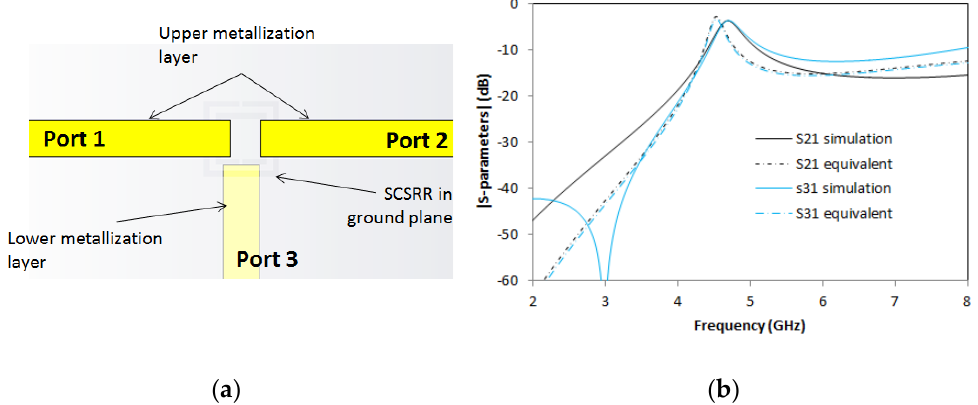
Figure 15. ( a ) Top view overlapped layer distribution of a 2-layer power divider. ( b ) Simulated S21 (solid black line) and simulated S31 (solid blue line). Equivalent circuit S21 (dashed-dotted black line) and equivalent circuit S31 (dashed-dotted blue line).